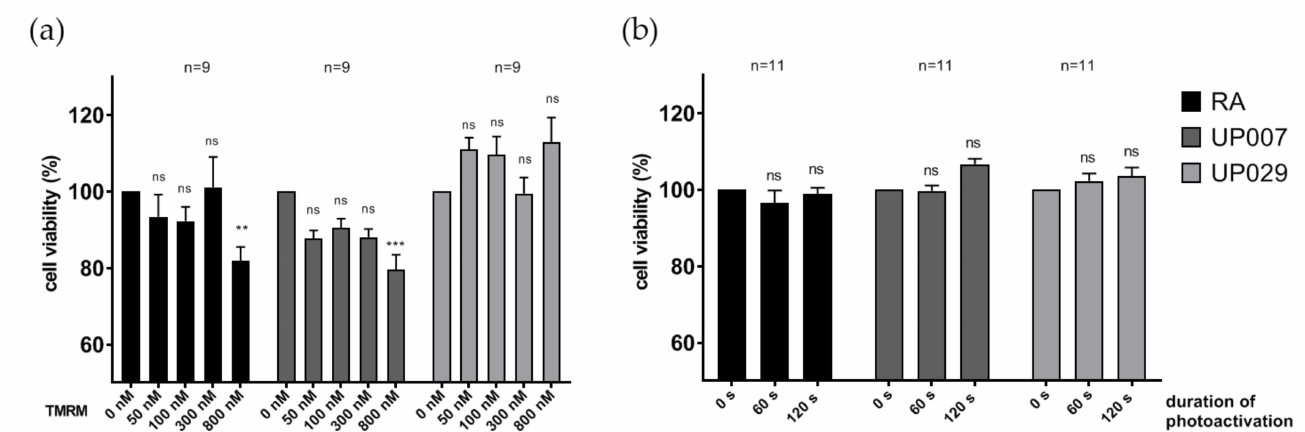
Figure 8. Further control experiments to assess the dark toxicity of TMRM and the effect of green light. ( a ) Prolonged incubation with TMRM for 48 h with no photoactivation had a minimal effect on GBM or RA cell density as measured using MTT assay. ( b ) When applied to unloaded cells, green light 1.4 mW/mm 2 ) on its own, had no effect on the survival of GBM cell lines or RA (PrestoBlue assay). N: is the total number of datapoints for each condition from 3 independent experiments (6 for RA in panel A.). (**) p < 0.01, (***) p < 0.001. ns—not